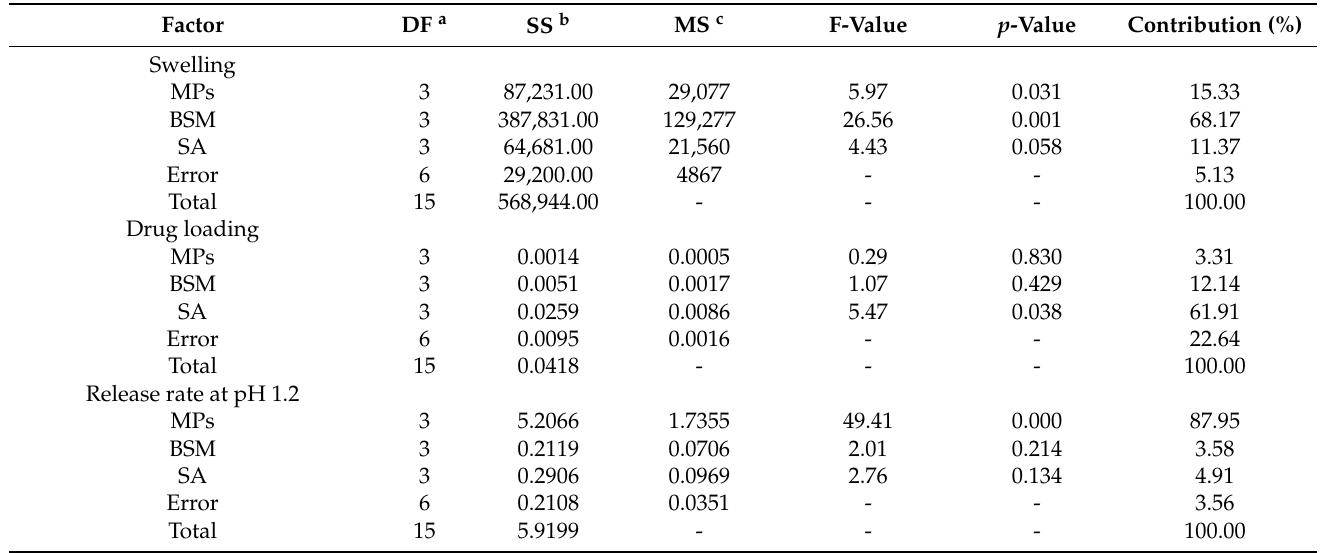
Figure 4. Swelling (– • –) and S/N (– (cid:4) –) ratios of the BSM/SA/MPs hydrogel beads. Table 1. ANOVA analysis